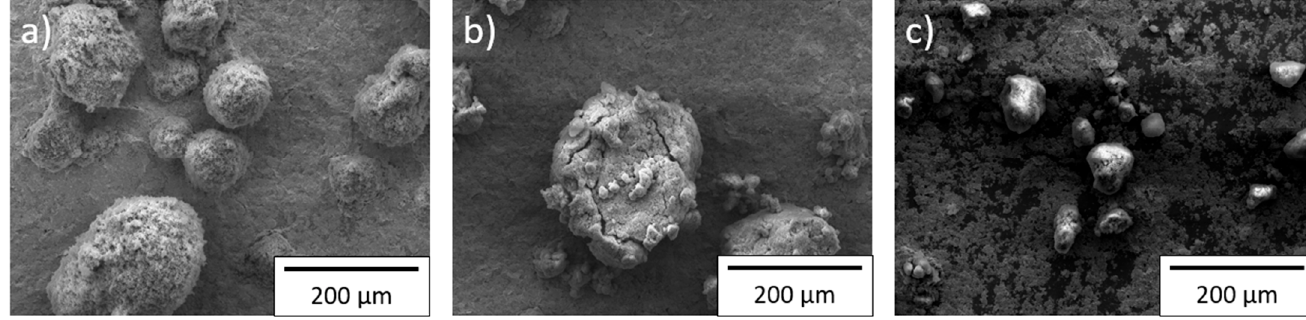
Figure A4. EDX measurements of the graphite electrode: ( a ) all detected elements, ( b ) carbon, ( c ) sodium, and ( d ) oxygen.